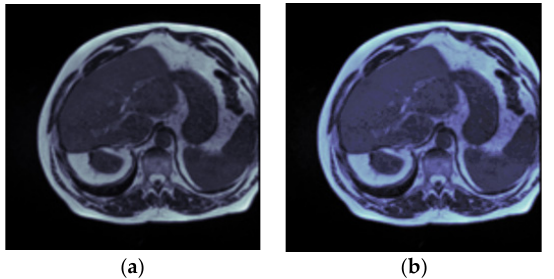
Figure 5. Data Normalization: ( a ) Input Image, ( b ) Normalized image.